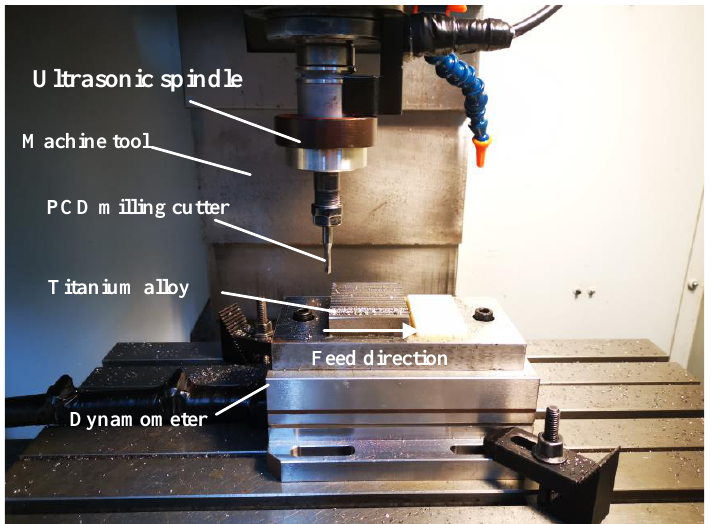
Figure 1. Cutting test apparatus.